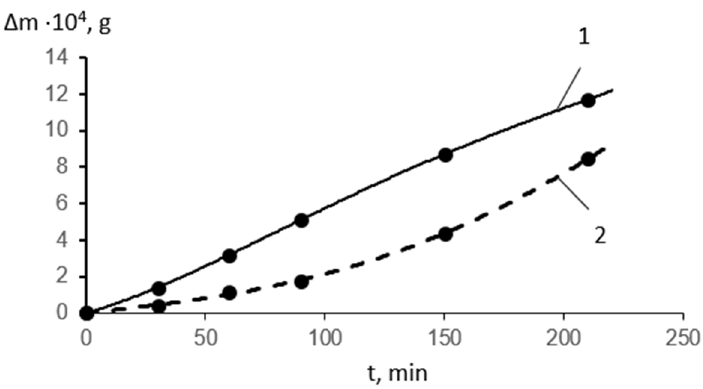
Figure 7. Kinetic curves of cavitation wear of steel 20 GL (1) and 30 L (2) samples.